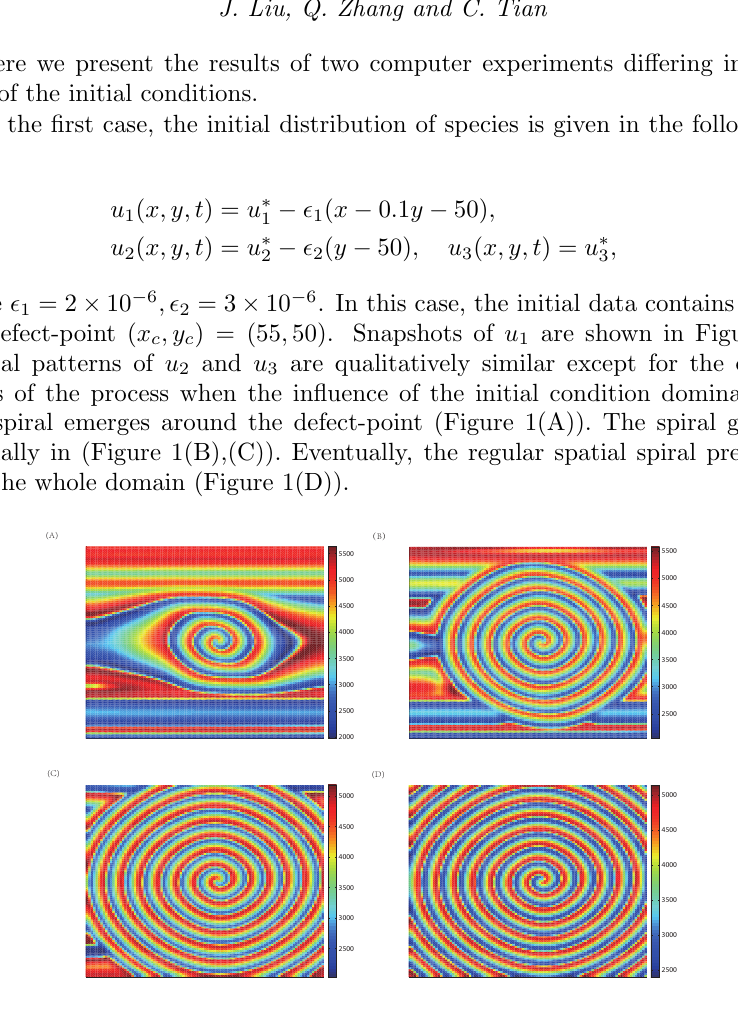
Figure 1. Example spatial patterns (snapshots of one spiral wave at different time for (A) t=400, (B) t=600, (C) t=800, (D)